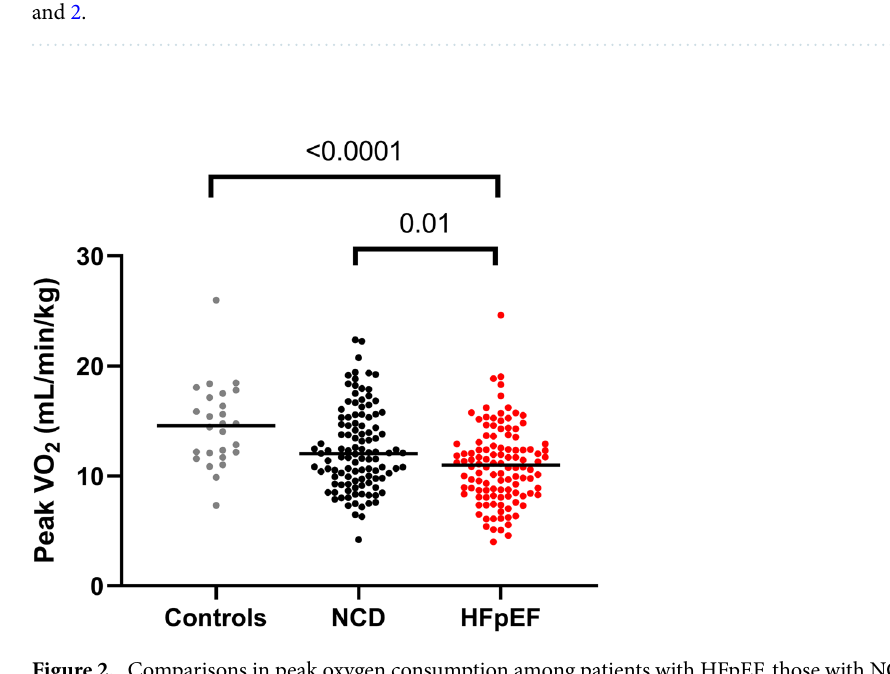
Figure 2. Comparisons in peak oxygen consumption among patients with HFpEF, those with NCD, and the controls. Abbreviations as in Fig.